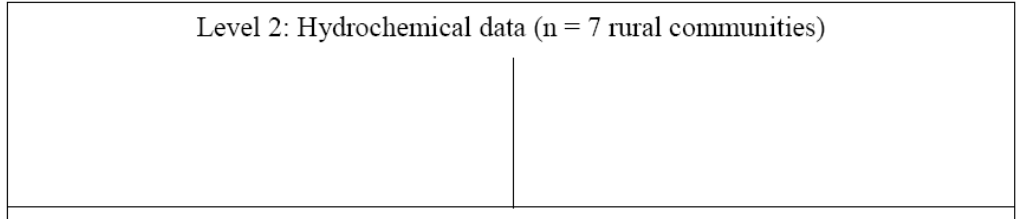
Figure 2. Hierarchical structure of hydrochemical data and variables with information at the individual